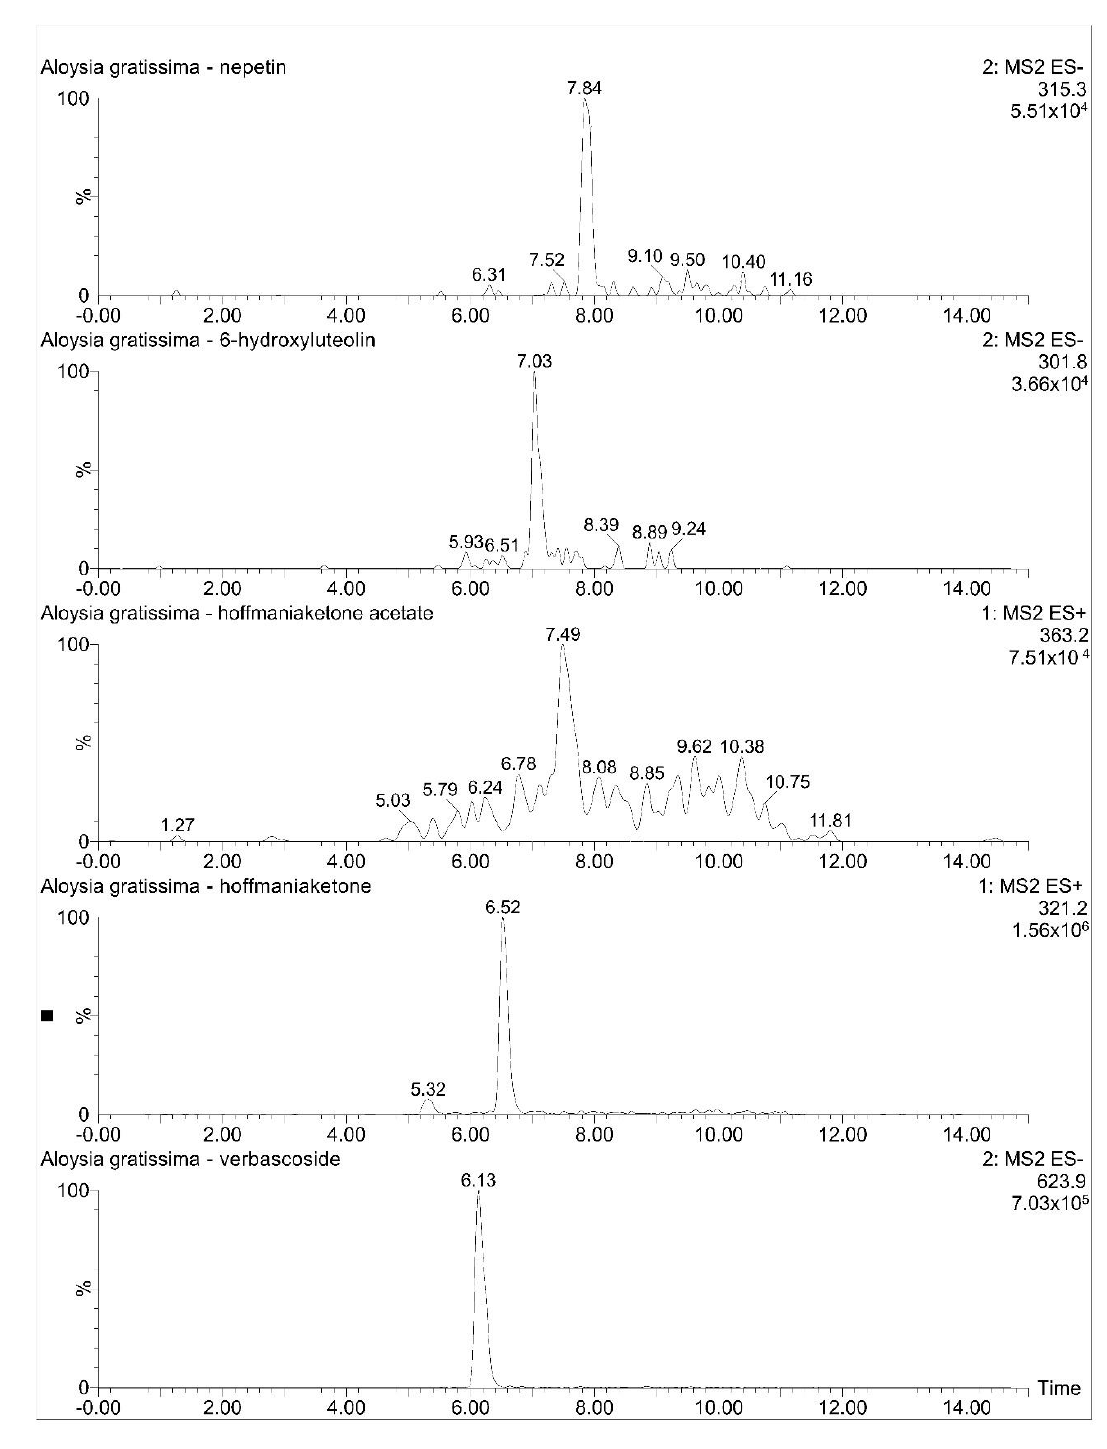
Figure 10. Extracted ESI-LCMS ion chromatograms from Aloysia gratissima var gratissima .